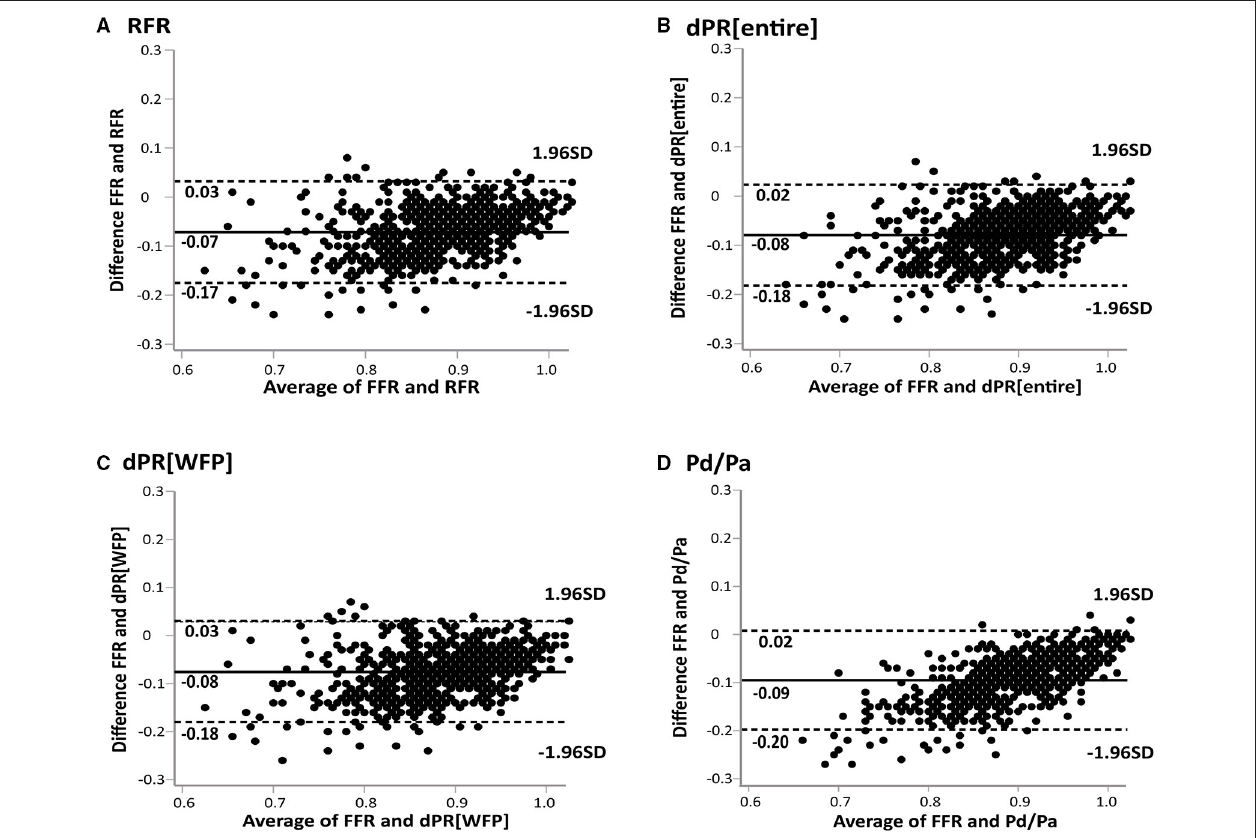
FIGURE 3 | Bland-Altman plots of differences against the means are displayed for RFR (A) , dPR[entire] (B) , dPR[WFP] (C) and Pd/Pa (D) . Solid lines represent the mean bias, enclosed by the limits of agreement (dashed lines). The Bland-Altman plots demonstrate a good agreement between FFR and NHPRs. dPR[entire], diastolic pressure ratio during entire diastole; dPR[WFP], diastolic pressure ratio during wave-free period; FFR, fractional flow reserve; NHPR, non-hyperemic pressure ratio; Pa, aortic pressure; Pd, distal coronary pressure; RFR, resting full-cycle ratio.